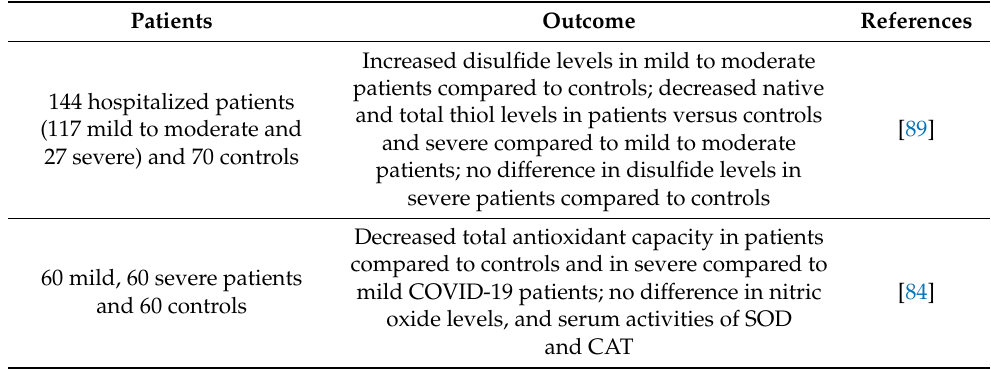
Table 2. Overview of studies that focused on COVID-19